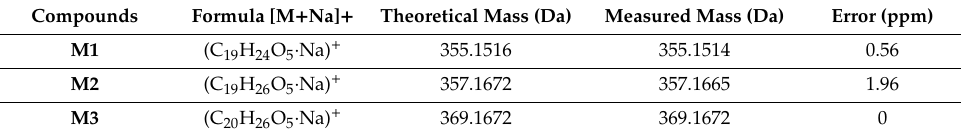
Table 3. LC-Q-TOF in the positive ion mode of CMX.